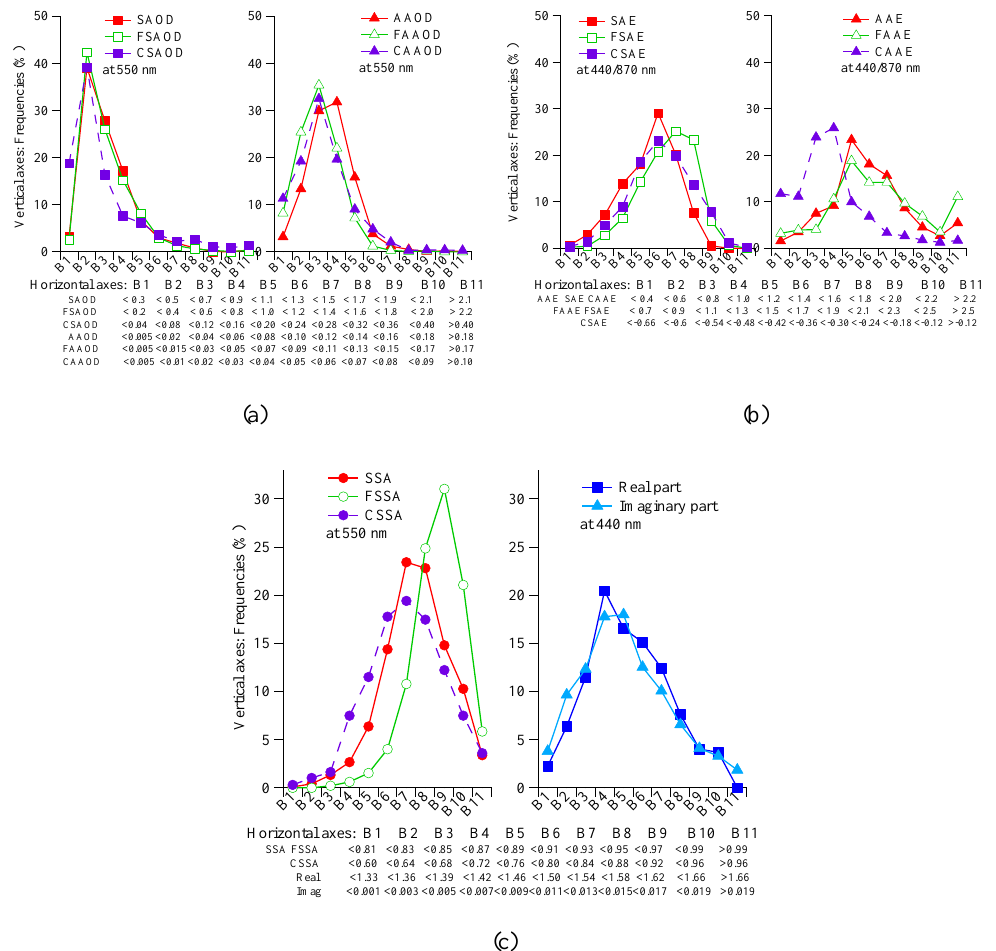
Figure 4. Frequency distributions of the size-dependent AODs at 550nm (a) , AEs at 440 / 870nm (b) , SSAs at 550nm (c) as well as the real and imaginary parts at 440nm (c) in the urban area of